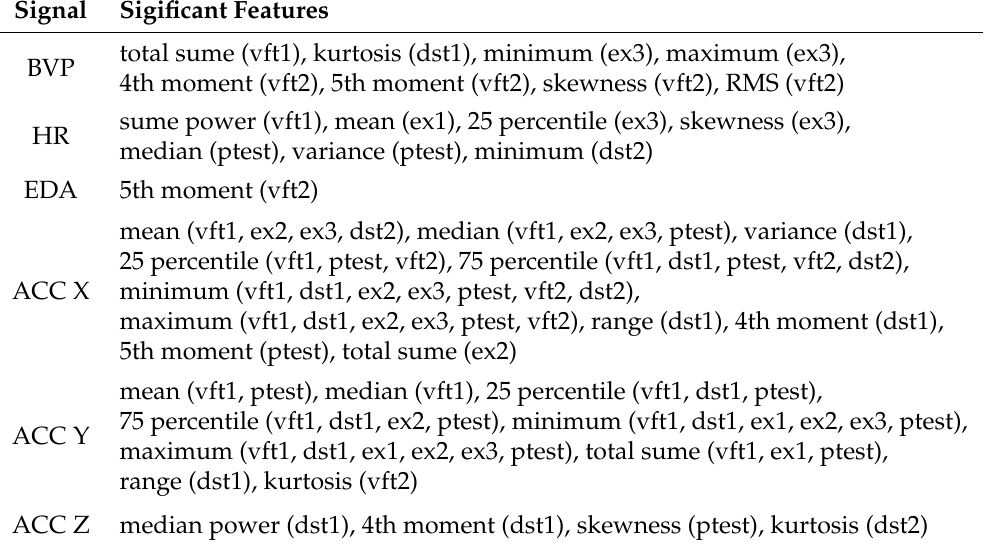
Table 1. Statistically significant features according to JAWS division, signal analysed, and proto- col